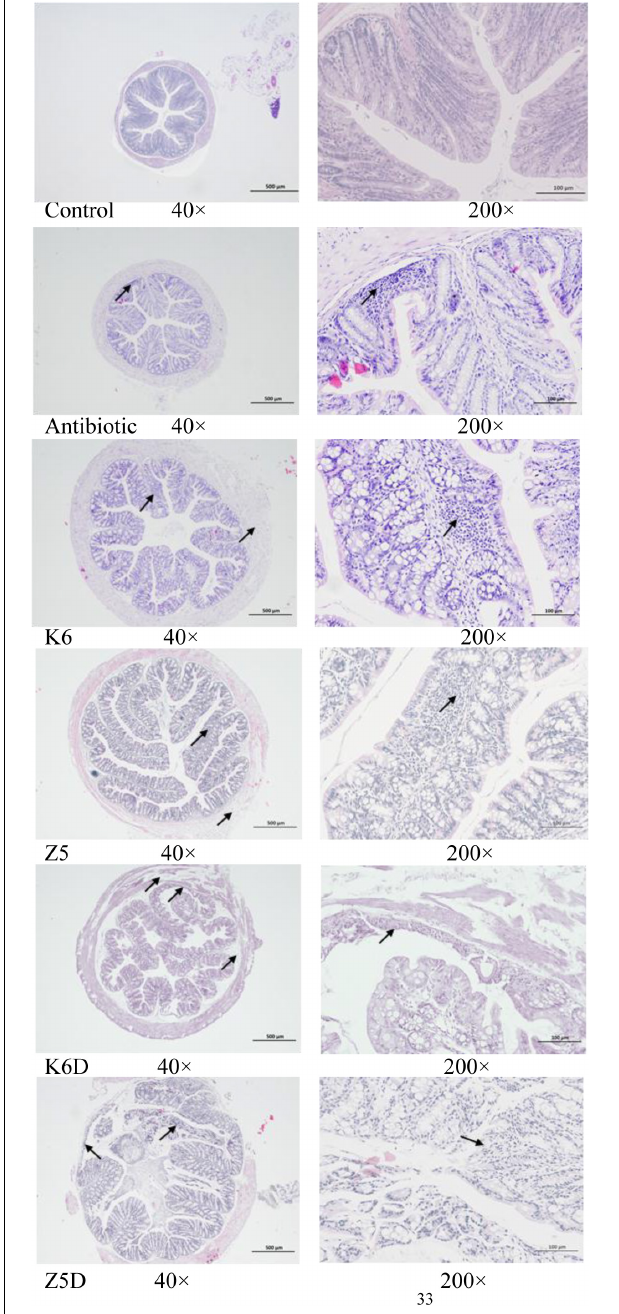
FIGURE 4 | Histopathological analysis of the effects of AMO-resistant K. variicola on mouse colons in the ABx-treated or DSS-induced colitis mouse model. Representative H&E staining of the proximal colon 7 days after treatment. The arrow indicates lesions. The scale bar is labeled in the image.